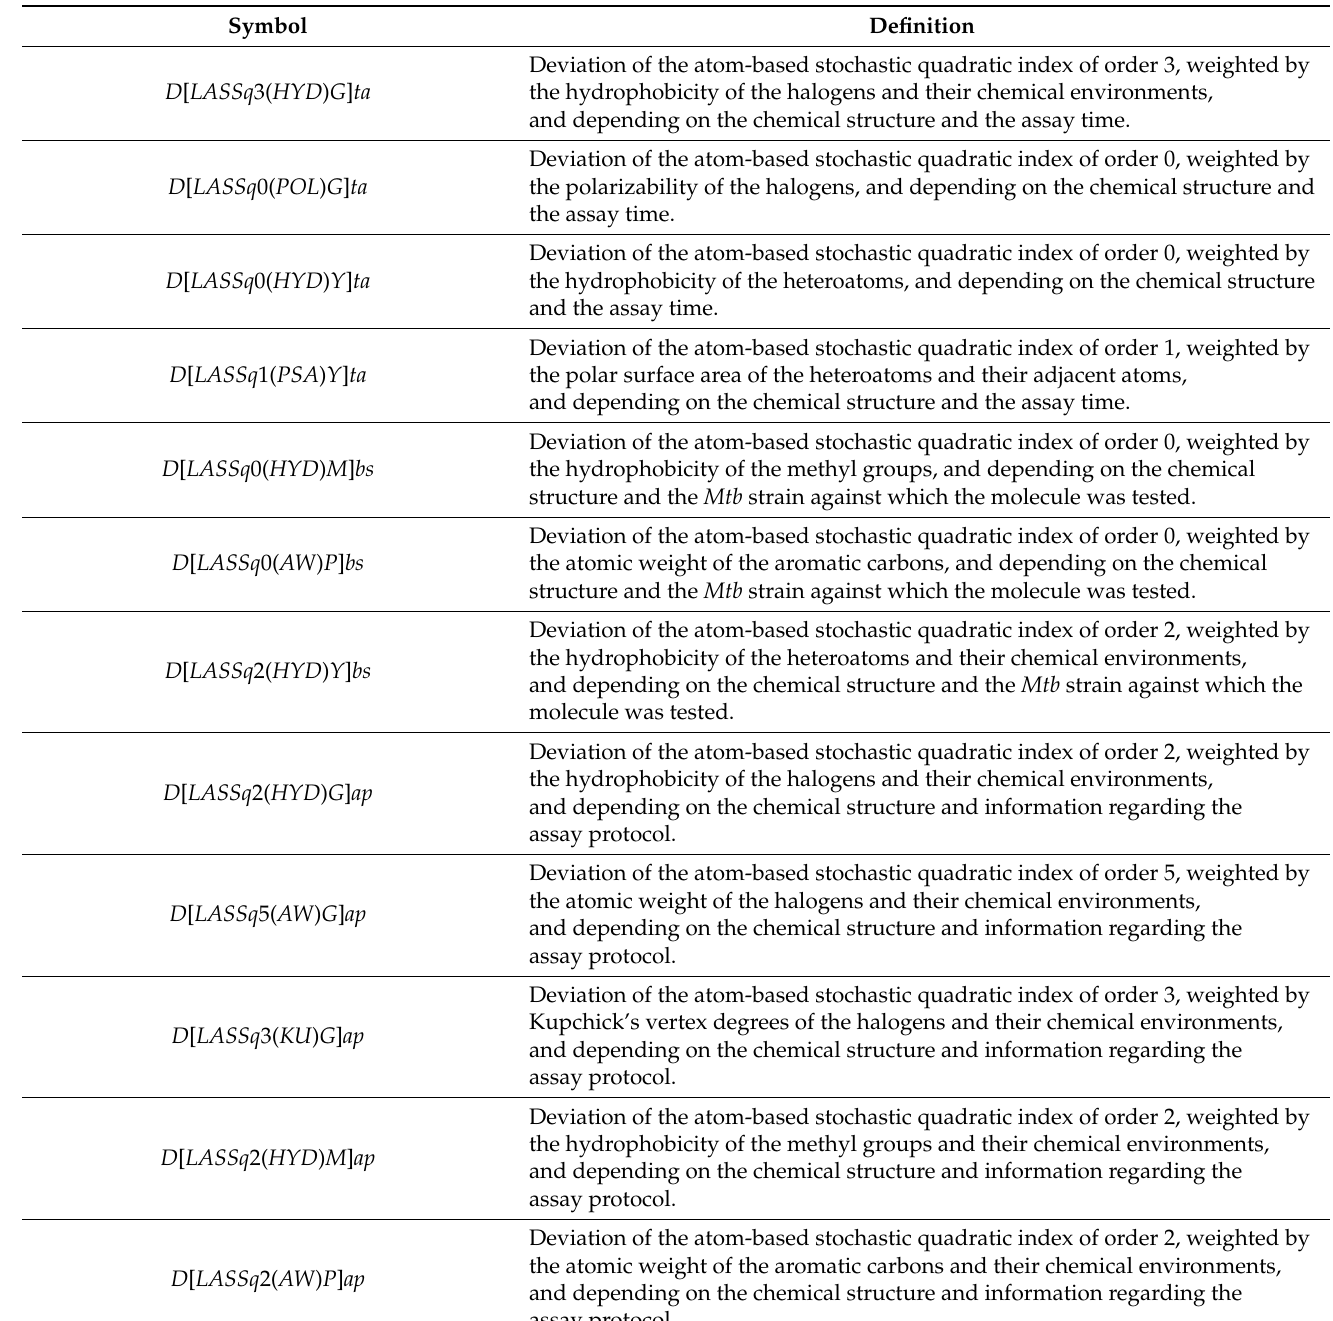
Table 1. Descriptors of the type D [ LQI ] cj which entered in the mtc-QSAR-EL